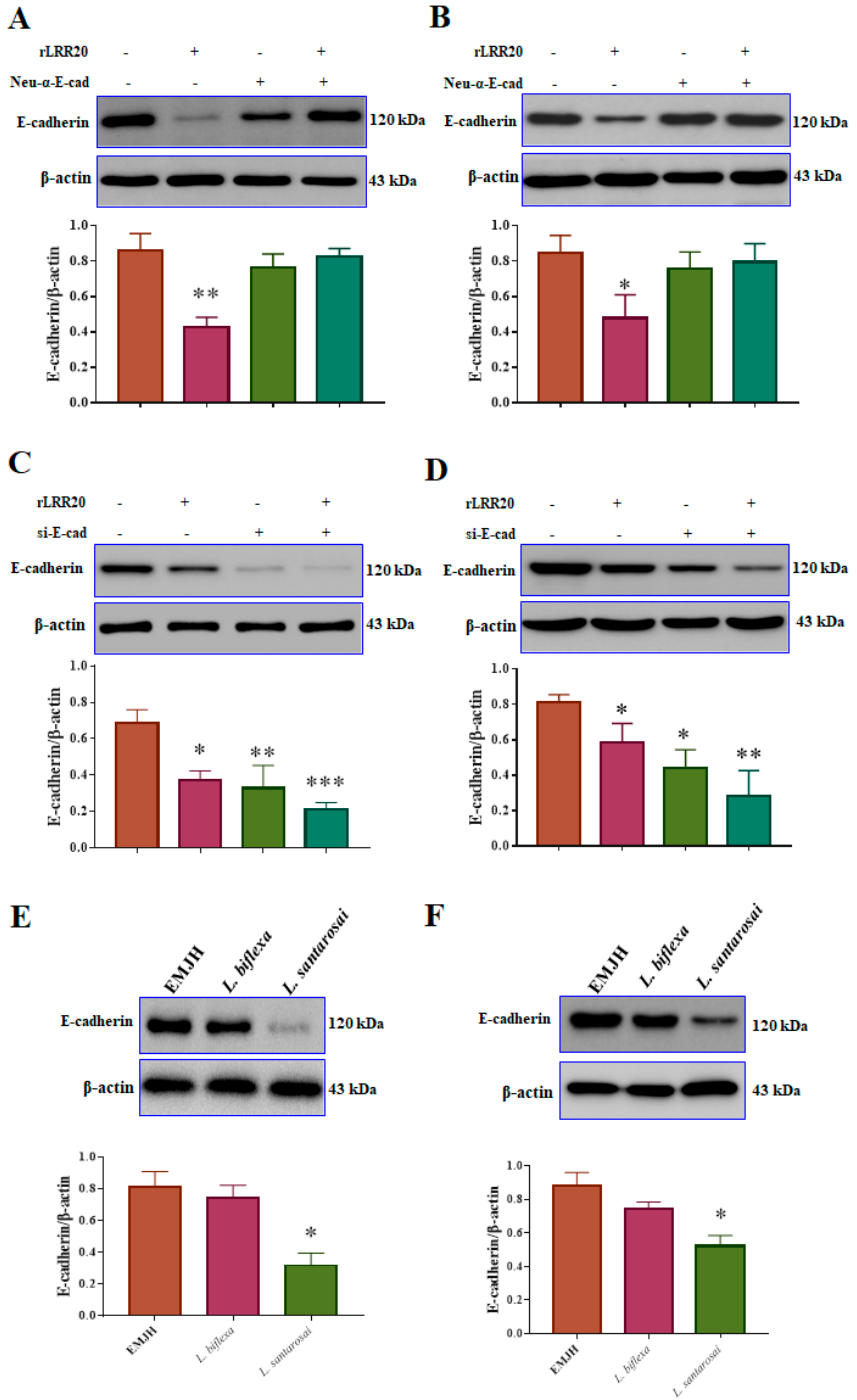
Figure 3. rLRR20 and Leptospira infection downregulated E-cadherin expression. Neutralizing anti-E-cadherin antibody (Neu- α -E-cad) and short interfering RNA against E-cadherin (si-E-cad) were used to verify the regulatory effects of rLRR20 on E-cadherin expression in HK2s and hRPTECs. Effect of α -E-cad, which inhibits the interaction between rLRR20 and E-cadherin, on the rLRR20-mediated degradation of E-cadherin in HK2s ( A ) and hRPTECs ( B ). Effect of si-E-cad on the rLRR20-mediated degradation of E-cadherin in HK2s ( C ) and hRPTECs ( D ). Effect of pathogenic ( L. santarosai ) and non-pathogenic ( L. biflexa ) Leptospira species on the E-cadherin levels in HK2s ( E ) and hRPTECs ( F ). β -actin was used as the internal control. EMJH, Ellinghausen–McCullough–Johnson–Harris medium. *** p < 0.001; ** p < 0.01; * p < 0.05.